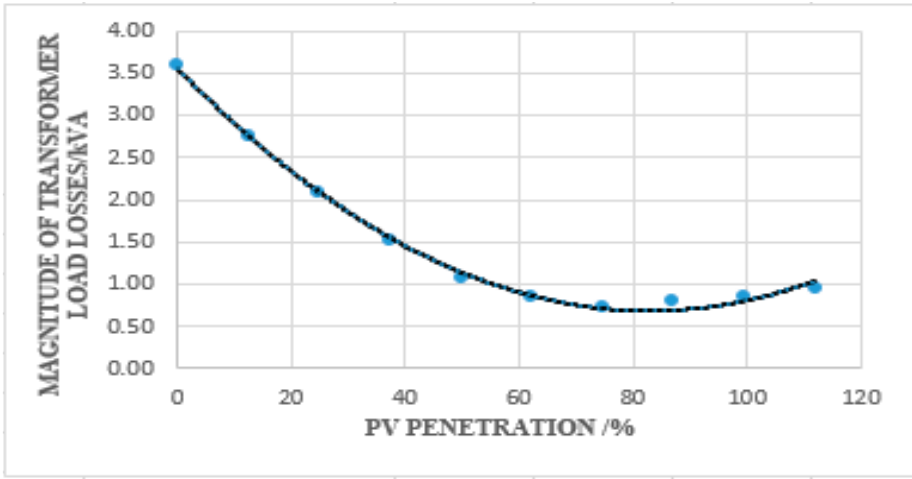
Figure 7. Graphical analysis of total transformer losses.